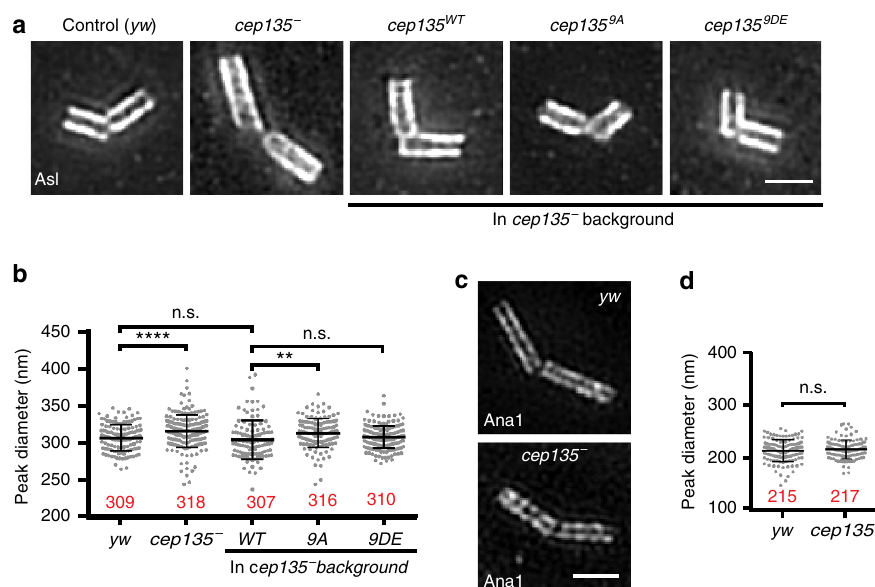
Figure 7 | Phosphorylation of Cep135 is critical for positioning Asl on centrioles. ( a ) SIM of Asl in spermatocyte centrioles from testes of the indicated genotypes. ( b ) The peak diameter of Asl in cep135 mutant centrioles is rescued by expression of Cep135 FL-WT and Cep135 FL-9DE , but not Cep135 FL-9A . Bars indicate the mean (red numbers) ± s.d.; Ns are centrioles— yw ¼ 138, cep135 ¼ 199, WT ¼ 112, 9A ¼ 132, 9DE ¼ 192; pooled from three experiments. ( c ) Ana1::tdtomato direct fluorescence in control (yw) and cep135 mutant centrioles. Loss of Cep135 does not affect Ana1 positioning. ( d ) Peak diameter measurements of Ana1-labelled spermatocyte centrioles. Ana1 position is unaffected by the absence of Cep135. Bars indicate the mean (red numbers) ± s.d. Number of centrioles measured—yw ¼ 124, cep135 ¼ 112. Comparisons made by unpaired t -tests, with Welch’s corrections when appropriate. **** P o 0.0001, ** P r 0.01, n.s., not significant. Scale bars, 1 m